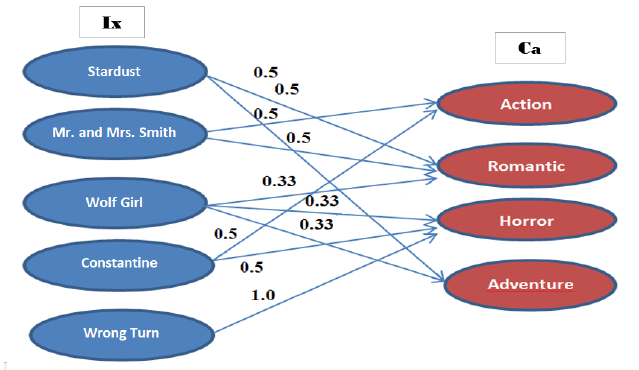
Figure 1. Bipartite graph based on items’ genre.